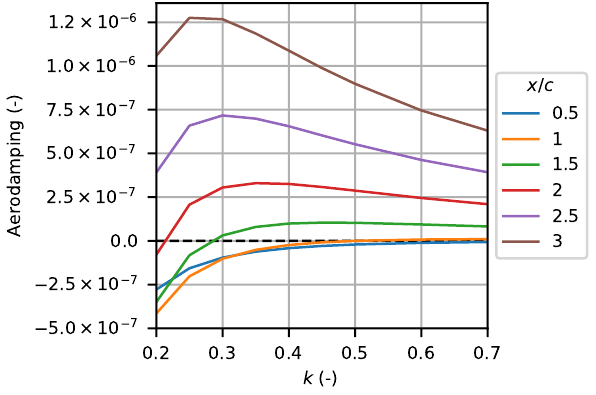
Figure 15. Effect of k on aerodamping at constant x / c —IBPA = 50°.